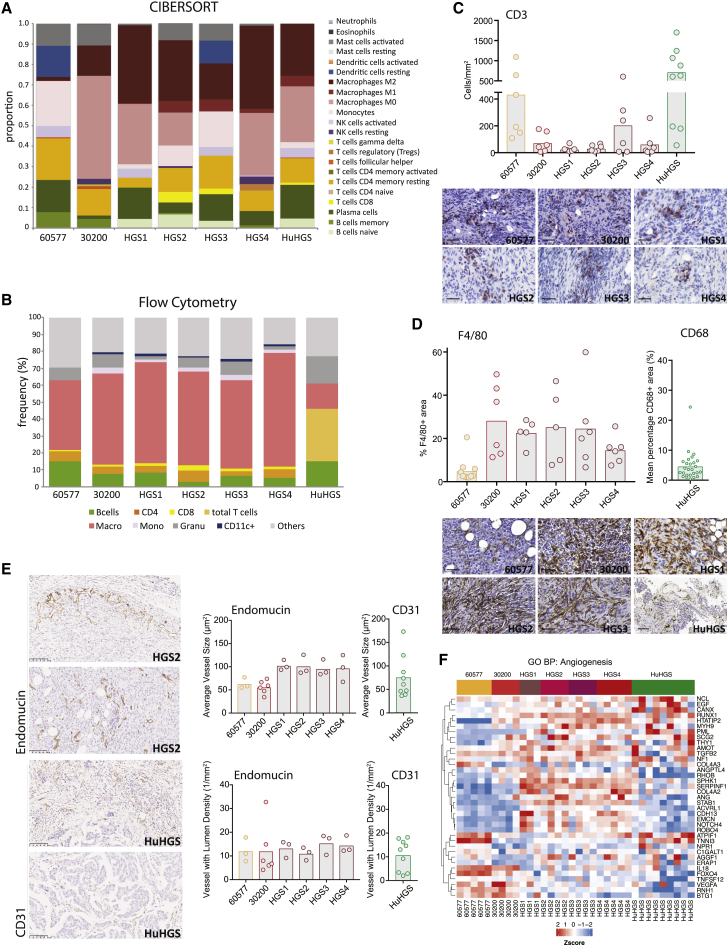
Immune Cells and Vasculature of the Murine and Human HGSOC(A) Proportions of immune cell populations estimated from murine tumors and human omental metastases using CIBERSORT. 30200, HGS2, and HGS3, n = 4; 60577 and HGS4, n = 5; HGS1, n = 3; human omental tumors, n = 9. Median values are depicted.(B) Flow cytometric analysis of the immune infiltrate of peritoneal tumors, close to endpoint, from mice injected with 60577, 30200, or HGS cell lines. B cells: CD45+ CD19+, CD4 cells: CD45+ CD3+ CD4+, CD8 cells: CD45+ CD3+ CD8+, monocytes: CD45+ CD11b+ Ly6C+, macrophages: CD45+, CD11b+ F4/80+ (Ly6C/G−), granulocytes: CD45+ CD11b+ Ly6G+, CD11c+ cells: CD45+ CD11b+ CD11c+ (F4/80− Ly6C/G−). A similar analysis of the immune infiltrate in the diseased omentum from patients who underwent upfront surgery is shown for comparison (HuHGS).(C) Quantification of the number of CD3+ cells/mm2 by IHC on peritoneal tumors from mice injected with 60577, 30200, or HGS cell lines. Quantification of CD3+ cells in biopsies from patients (HuHGS) is shown for comparison. Representative images are shown; scale bars set to 100 μm.(D) Quantification of the percentage of an area positive for F4/80 by IHC on peritoneal tumors from mice injected with 60577, 30200, or HGS cell lines. Quantification of CD68+ area in patient biopsies is included for comparison. Representative images are shown; scale bars set to 100 μm.(E) IHC for endomucin (mouse) and CD31 (human) staining, quantified using the Definiens Tissue Studio platform with the blood vessel detection feature. Each dot represents a tumor from an individual mouse or human. Representative images for HGS2 and HuHGS are depicted at left. Scale bars, 100 μm.(F) Heatmap illustrating Gene Ontology biological process angiogenesis gene expression across mouse models and human omental tumors.